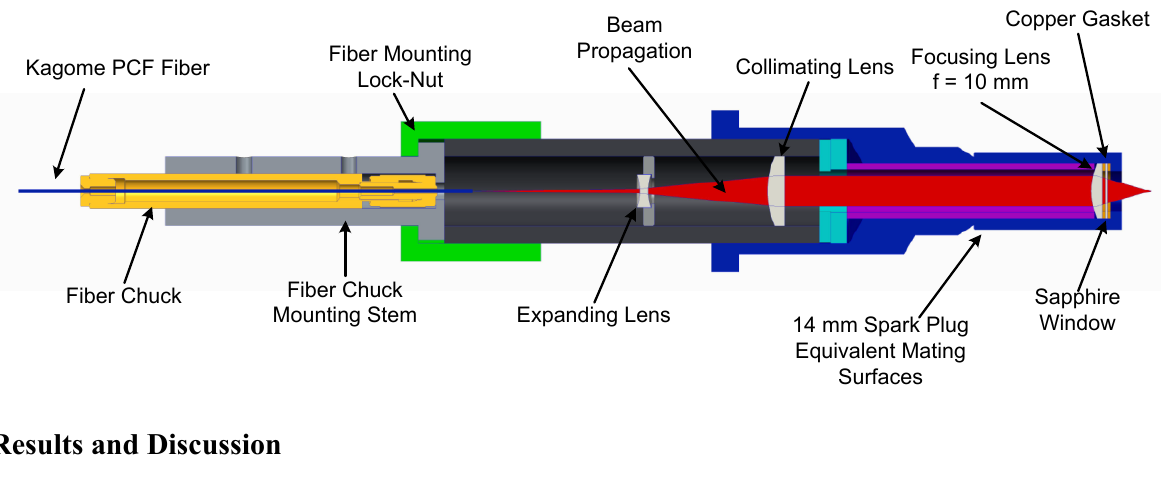
Figure 3. Assembly view of the optical spark plug